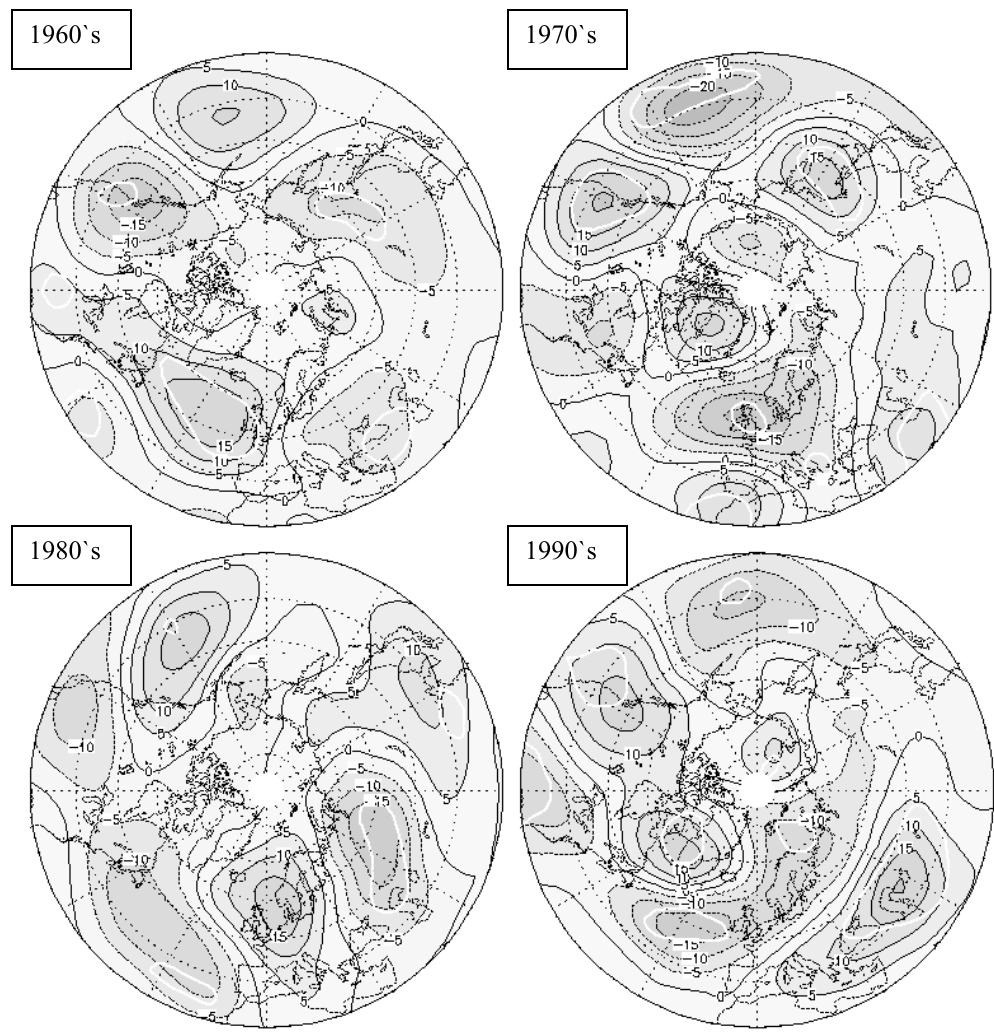
Fig. 1. Decadal change in mean geopotential height perturbations at the 300-hPa layer for December as linear regression with time (m/yr). White line encloses area of significance ( > 95%).